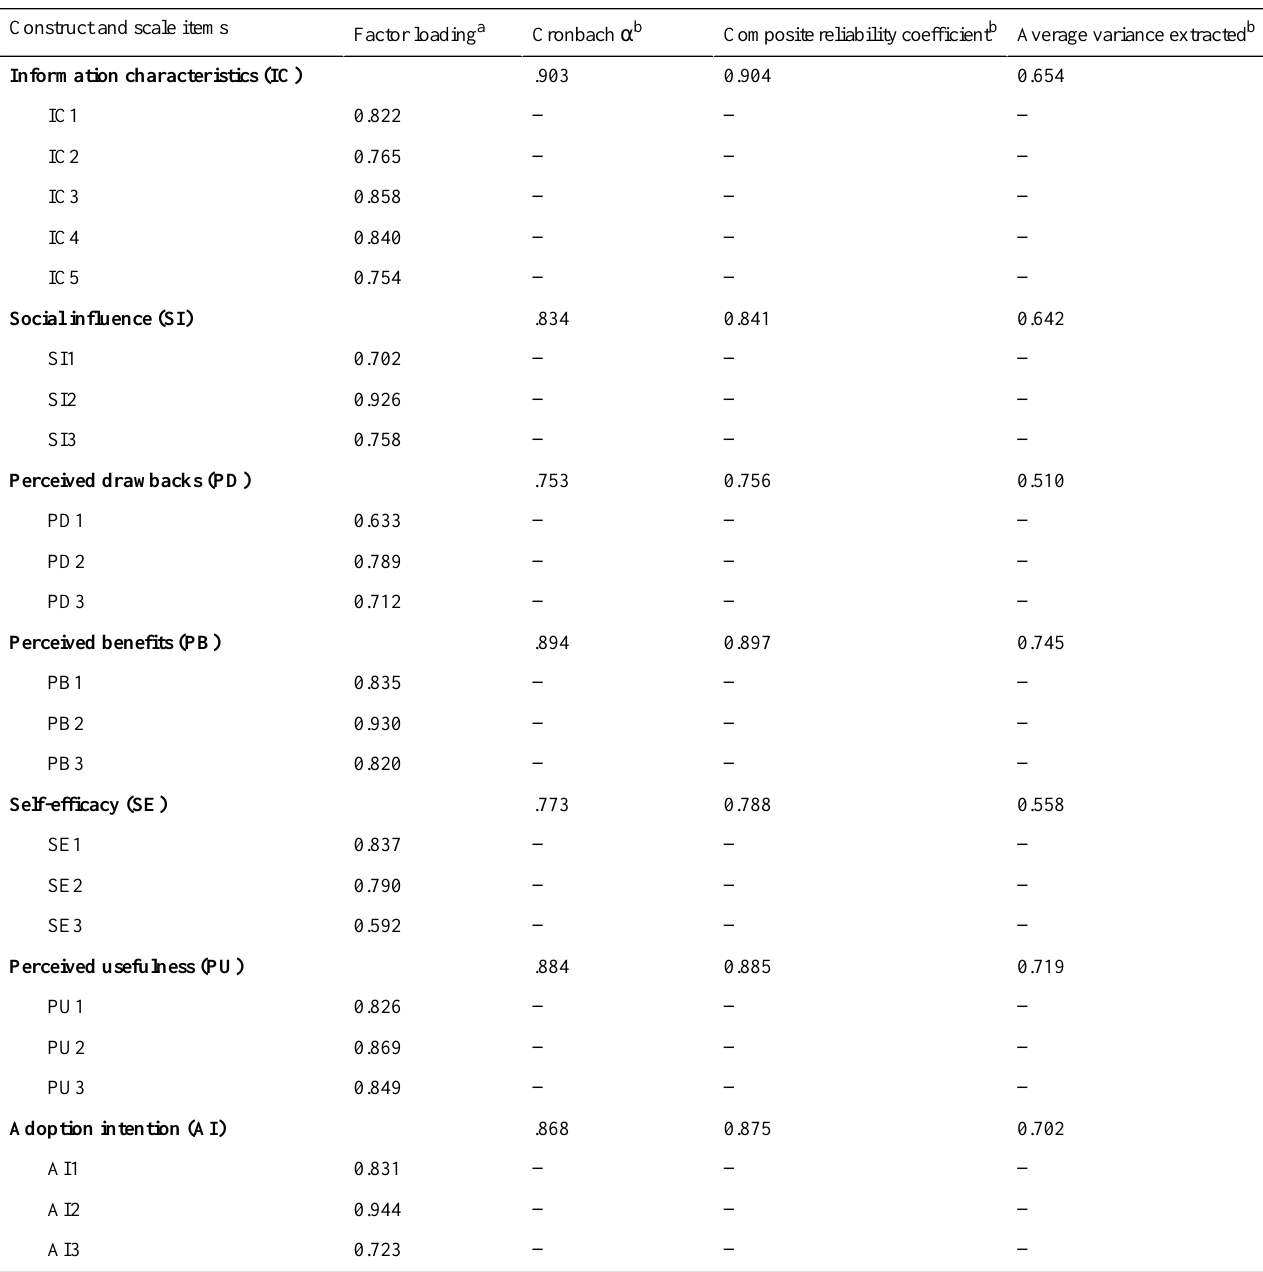
Table 3. Reliability and convergent